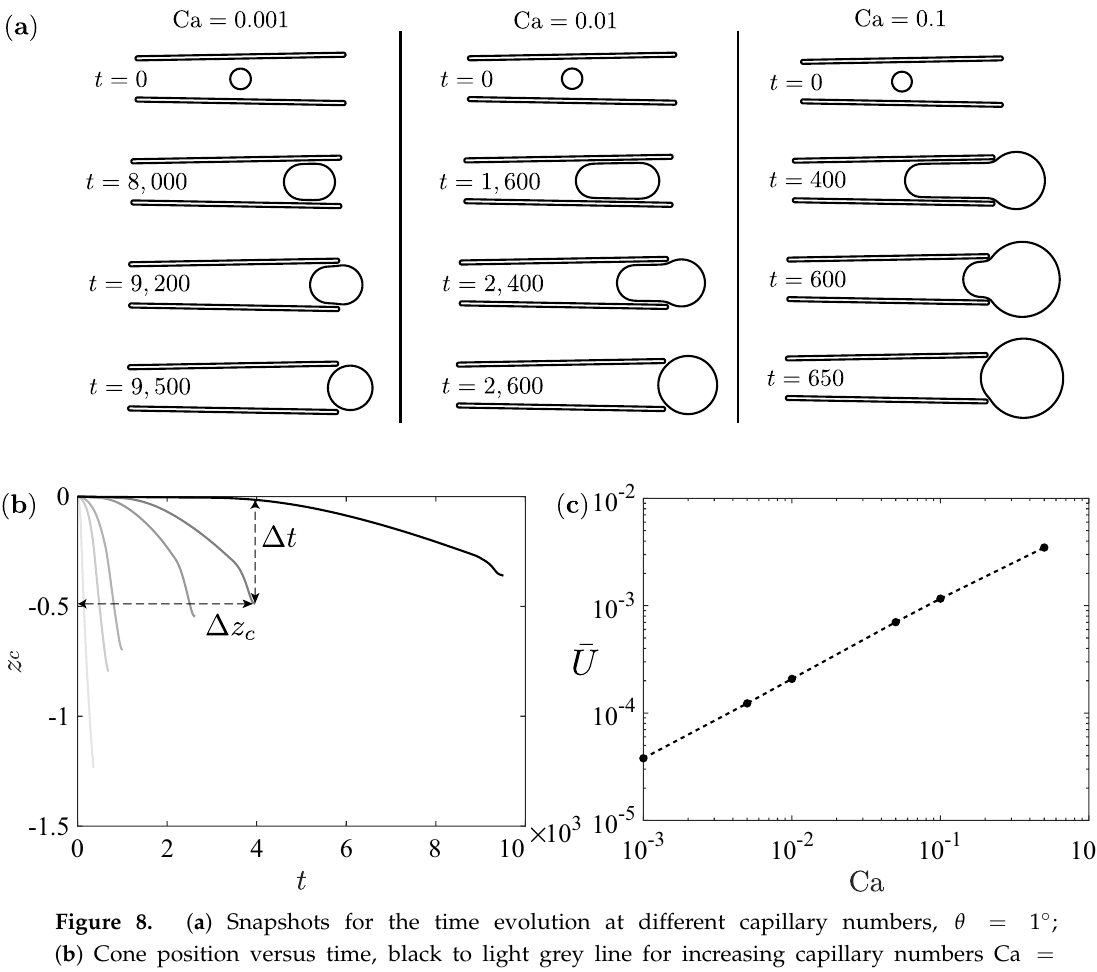
Figure 8. ( a ) Snapshots for the time evolution at different capillary numbers, θ = 1 ◦ ; ( b ) Cone position versus time, black to light grey line for increasing capillary numbers Ca = [ 0.001,0.005,0.01,0.05,0.1,0.5 ] ; ( c ) Average velocity versus capillary number.